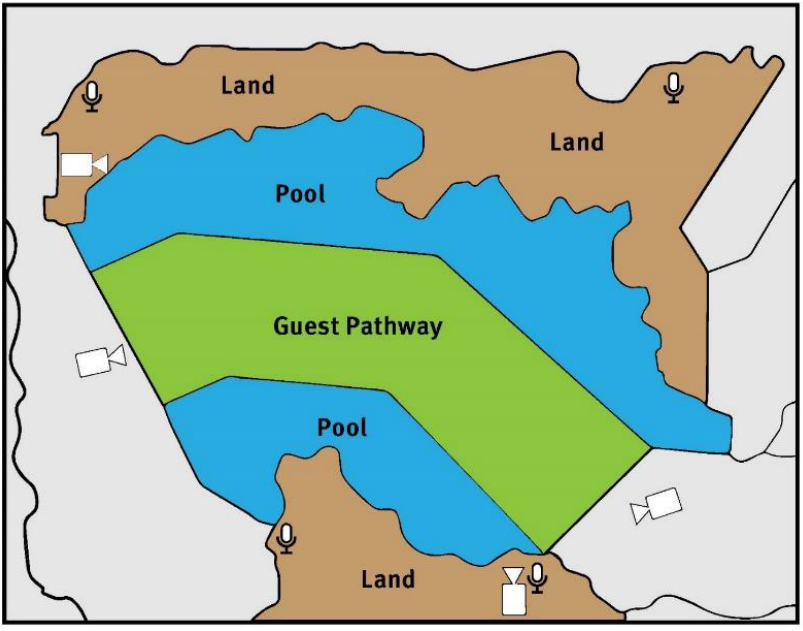
Note . Placement of video and sound recorders identified with camera and microphone icons.